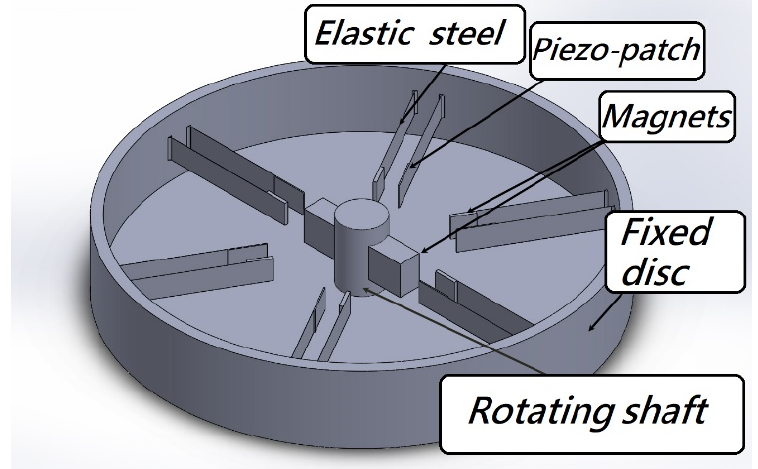
Figure 2. Extended System Design.